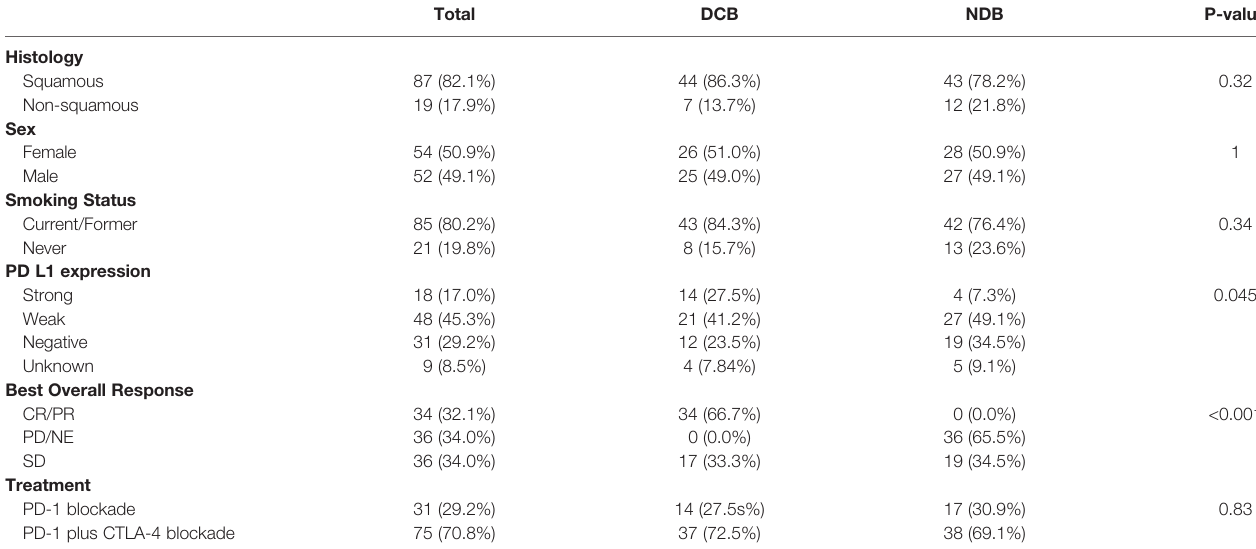
TABLE 1 | Clinical characteristics of discovery cohort.